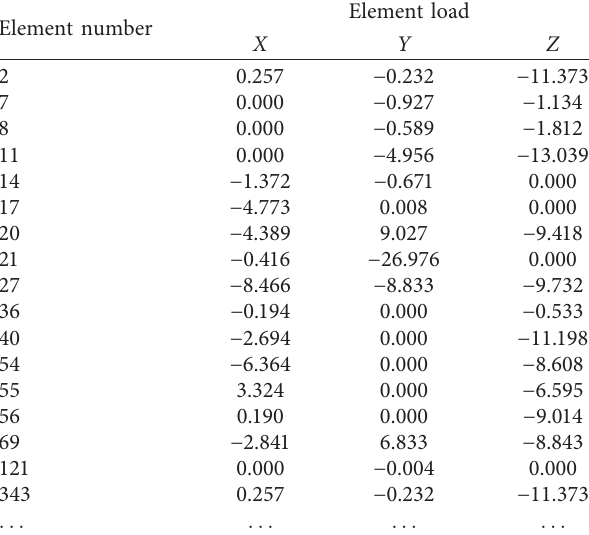
Table 3: Conversion between element force and node